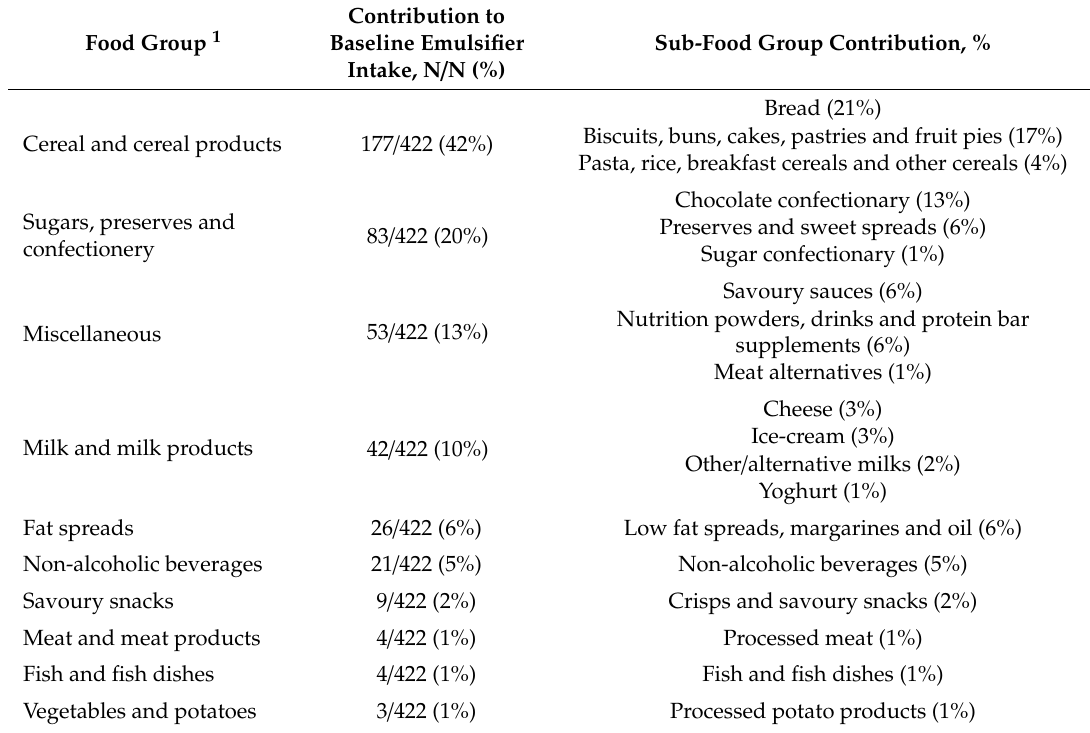
Table 2. Food groups contributing to frequency of emulsifier exposure in 20 patients with Crohn’s disease in baseline habitual